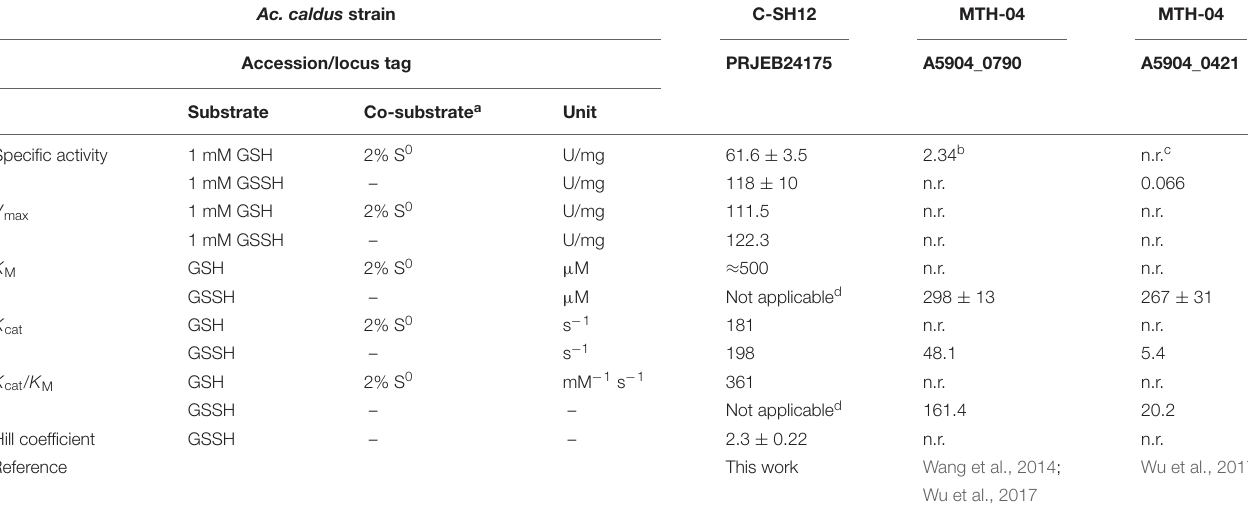
TABLE 1 | Comparison of the activity measurements and kinetic constants obtained of PDOs from Ac. caldus C-SH12 and MTH-04.